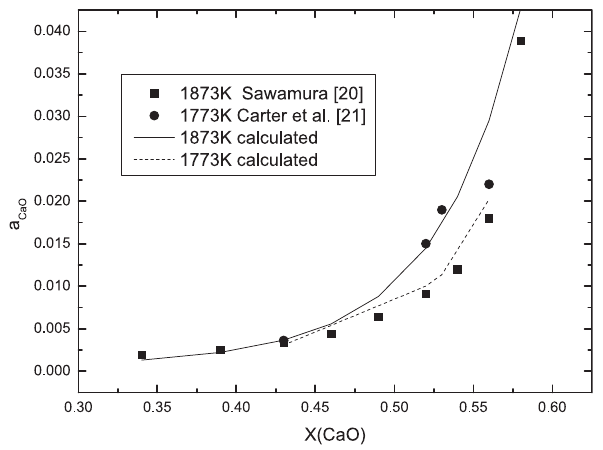
Fig. 4: Comparison between calculated and experimental activity [20, 21] of CaO (with solid CaO as standard state) in CaO-SiO 2 system